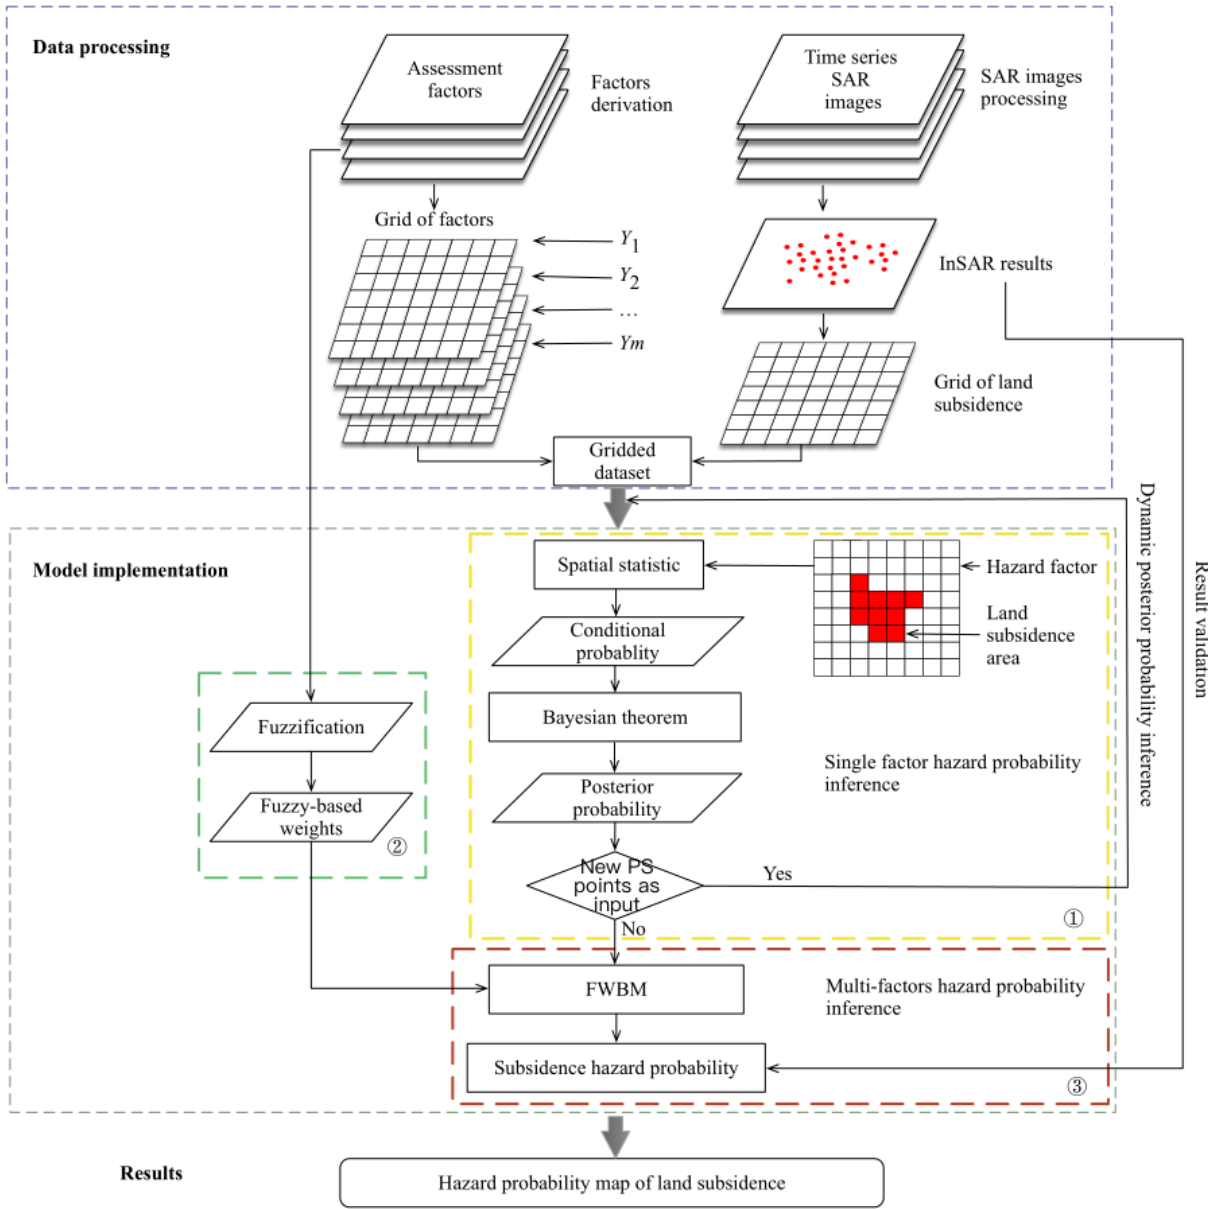
Figure 2. Flowchart of subsidence hazard assessment using the